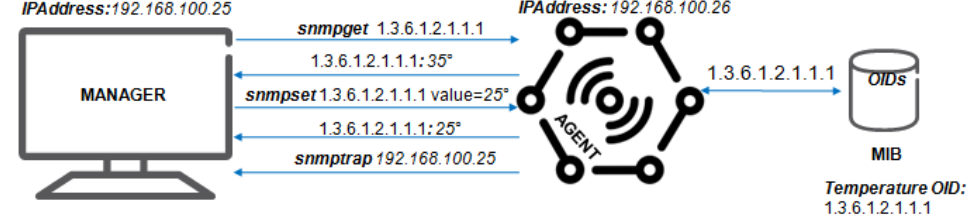
Figure 6. Illustration of the SNMP protocol for IoT devices.